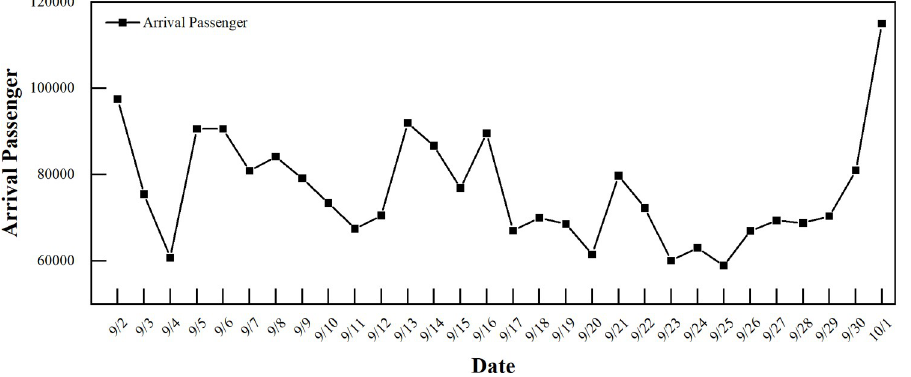
Fig 2. Distribution of the daily arrival passenger flow in the arrival